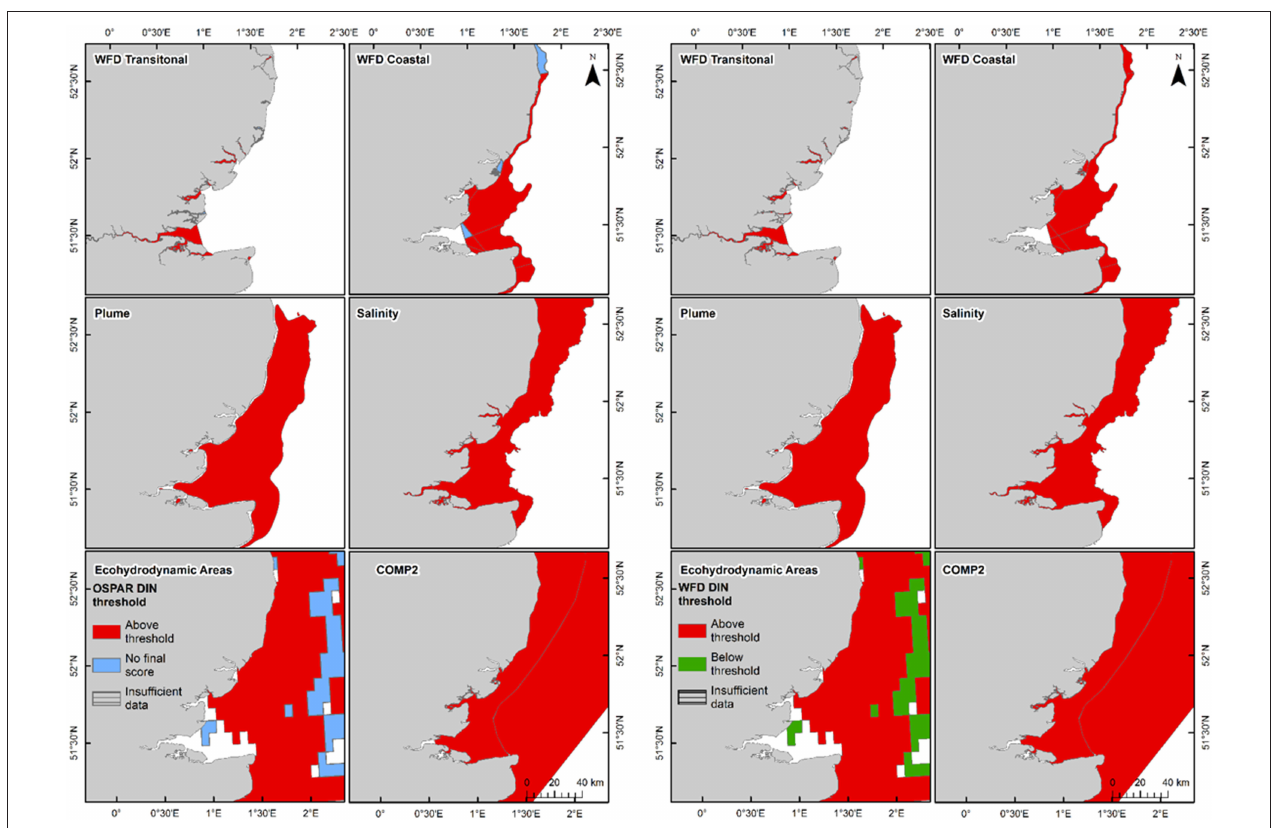
FIGURE 5 | Outcomes for the OSPAR DIN assessment (left) and WFD DIN assessment (right) for Thames